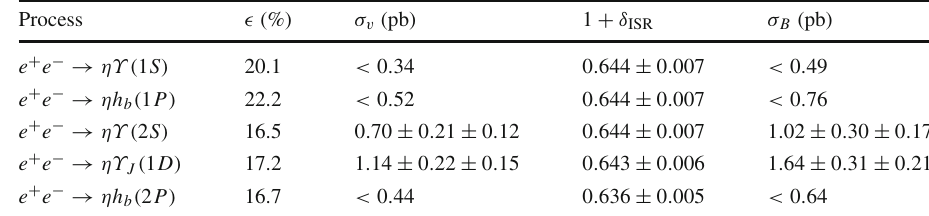
Table 3 Systematic uncertainties, in percentage, on the measurement of the Born-level cross sections of the e + e − → η b ¯ b processes Source